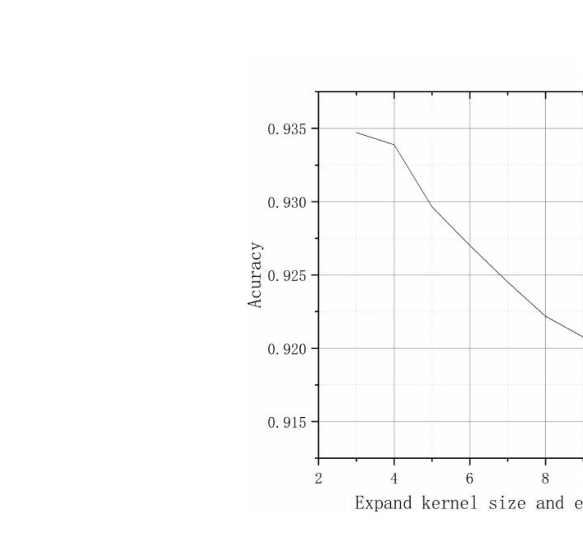
FIGURE 10 Confusion matrix veri fi cation accuracy curve after clustering process.